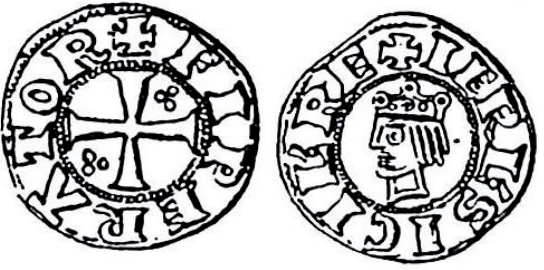
Figure 2. Denaro of Frederick II of Hohenstaufen, obverse and reverse sides of a silver coin, 1225. Pen drawing published in [12] (Figure 22).